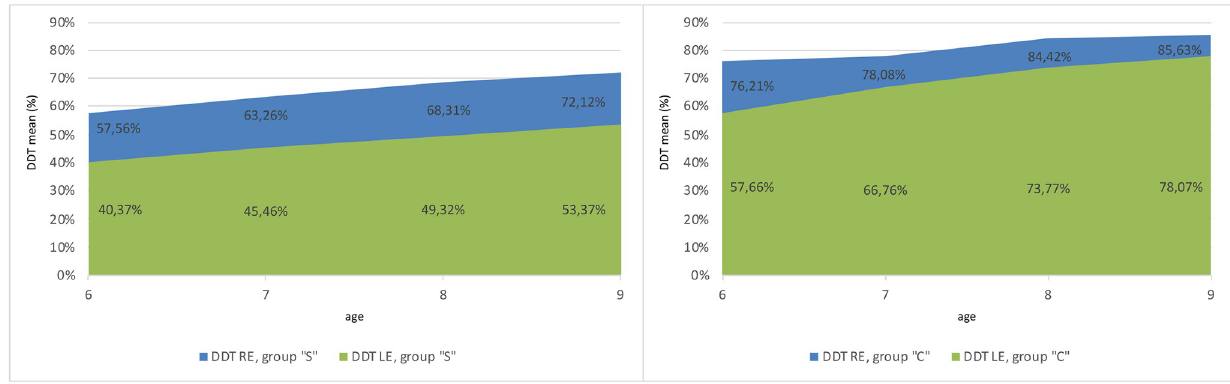
Fig 11. Comparison of mean results for DDT RE and LE (dependent samples) in both groups illustrates right ear dominance in groups”S” and”C”, which decreases with age.